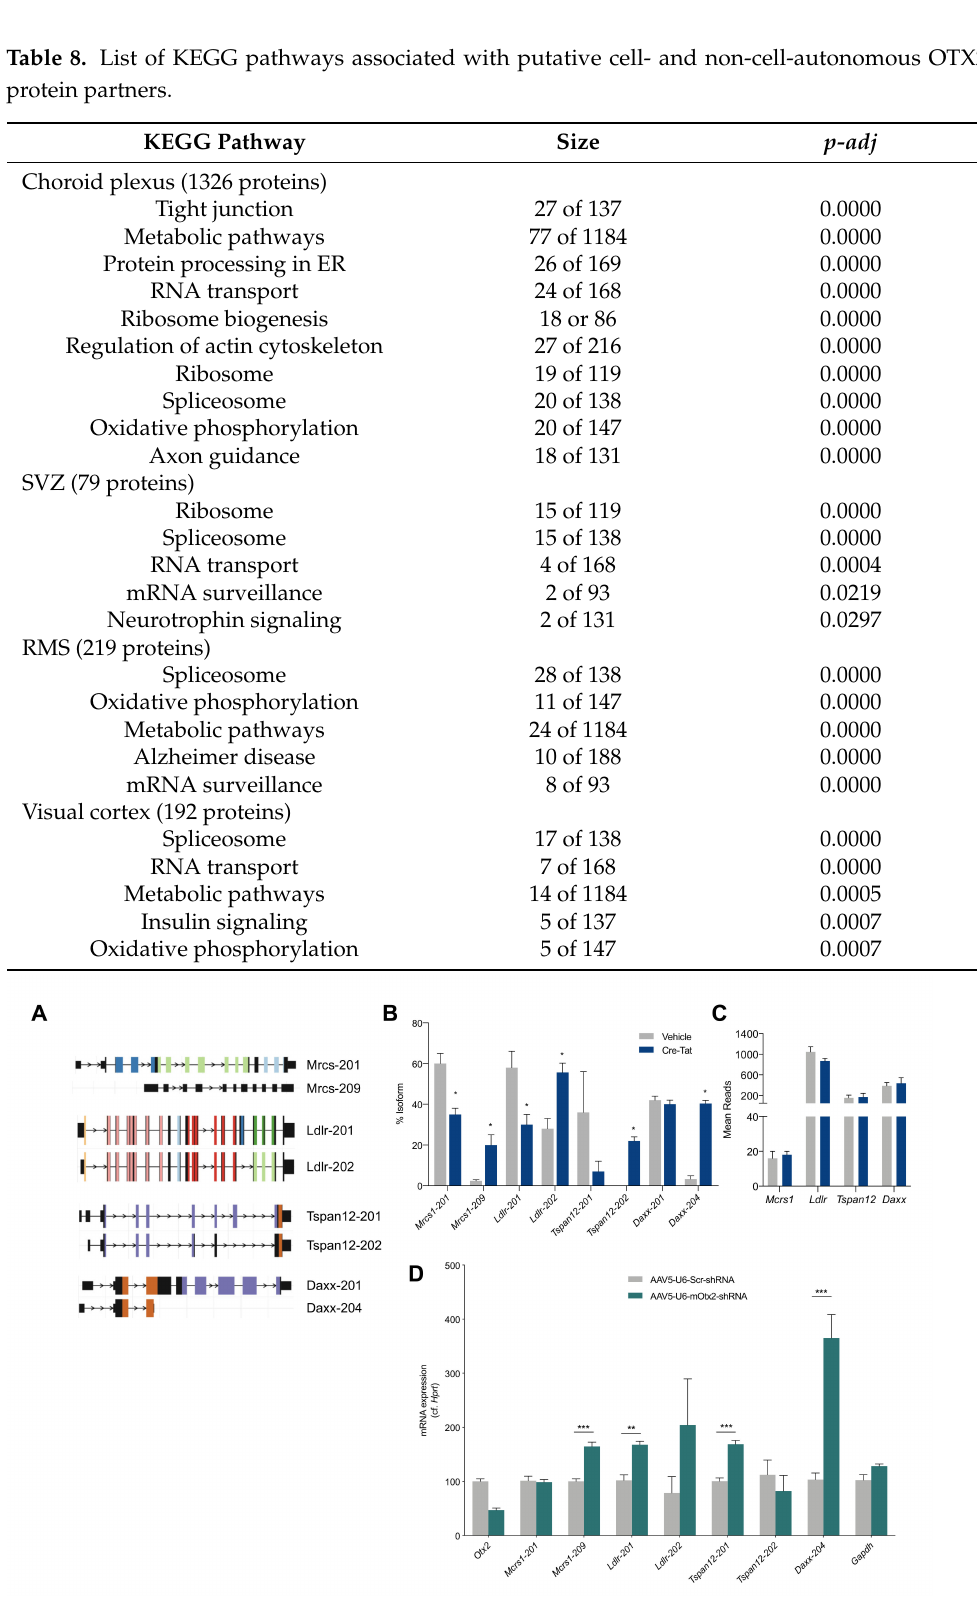
Figure 4. Analysis of splice variations induced by Otx2 knockdown in choroid plexus. ( A ) Selected isoforms of genes of interest. Locus length is in arbitrary units. Colors represent different protein